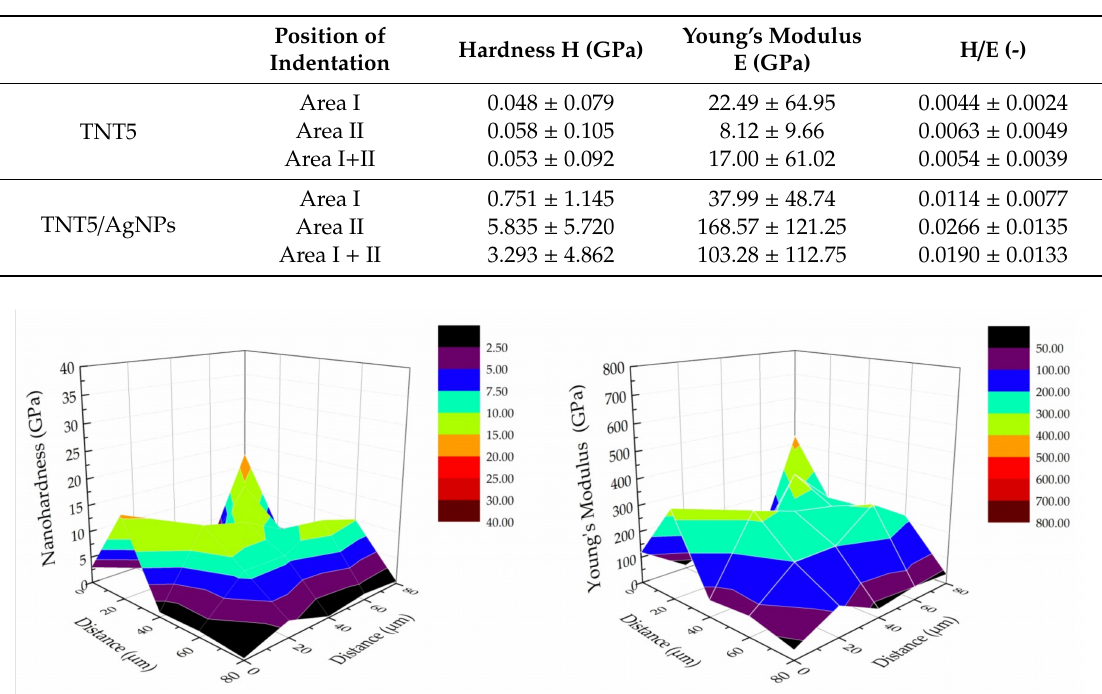
Table 4. Nanomechanical and nanoindentation properties of the tested implant samples.